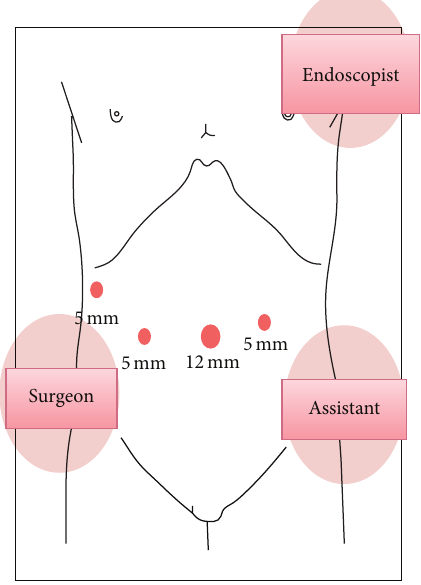
Figure 1: Setup for EALFTR. The surgeon stood on the patient’s right side with the assistant and laparoscopist on the patient’s left sideandtheendoscopicoperatorontheleftsideofthepatient’shead. EALFTR: endoscopy-assisted laparoscopic full-thickness